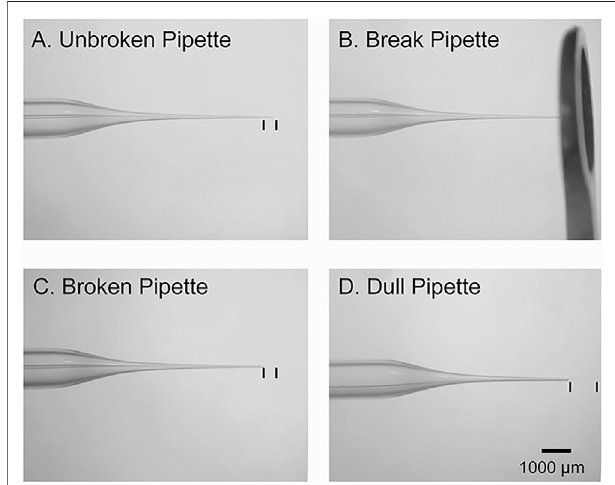
FIGURE 2 | Micropipette preparation. (A) : Image of an intact glass micropipettethatwasgeneratedbyaverticalpuller.Theblacklinesdenotethe amount of tip that should be removed prior to insertion into the embryo. (B) : Image of the large round forceps used to break the tip of micropipette. (C) : Image of an adequately broken micropipette with an ∼ 45-degree-tip. The black lines denote the amount of tip that was removed. (D) : An example of a dull pipette. The black lines denote the amount of tip that was removed.